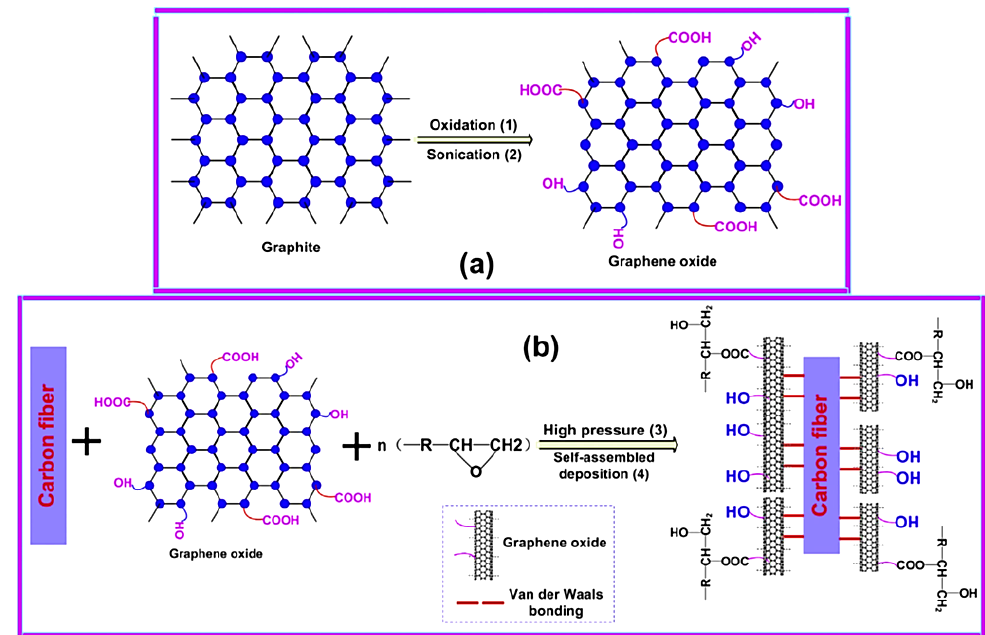
Figure 10. ( a ) Illustration of graphite stack oxidized to separate individual layers of GO; and ( b ) role of GO in interfacial bonding between carbon fiber and epoxy-based SMP matrix via van der Waals bonding and covalent cross-linking, respectively [120]. GO = graphene oxide; SMP = shape memory polymer. Reproduced with permission from Elsevier.